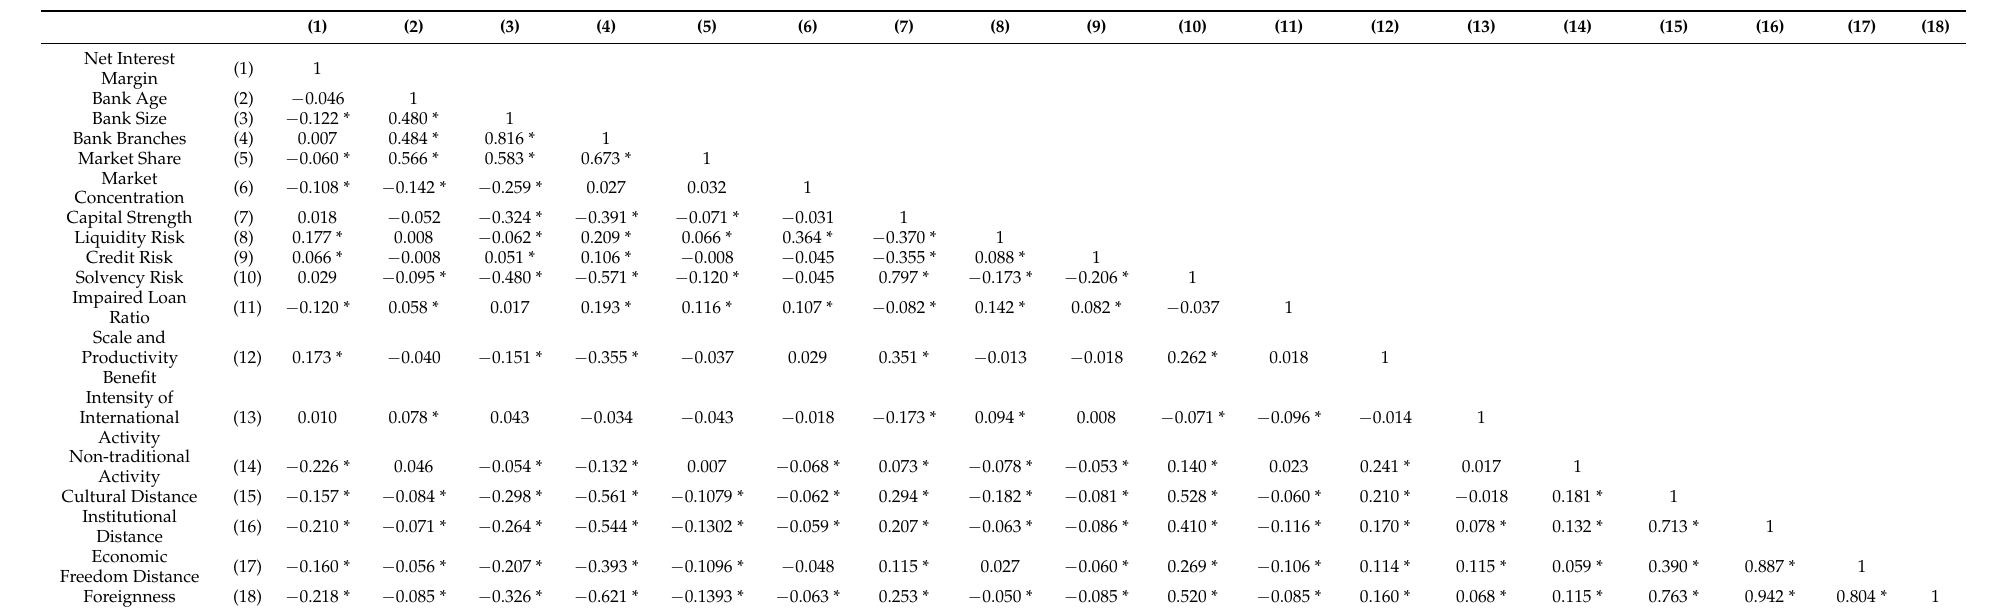
Table 4. Correlation coefficients between